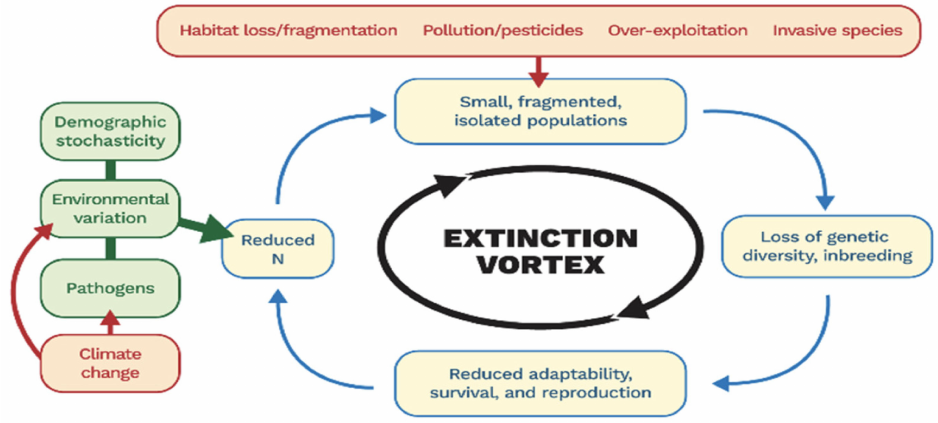
Figure 1. Multiple synergistic threats (red) exacerbate natural variation (green) and reduce diversity (gold) to perpetuate species extinction vortex (redrawn and edited from [11] Figure